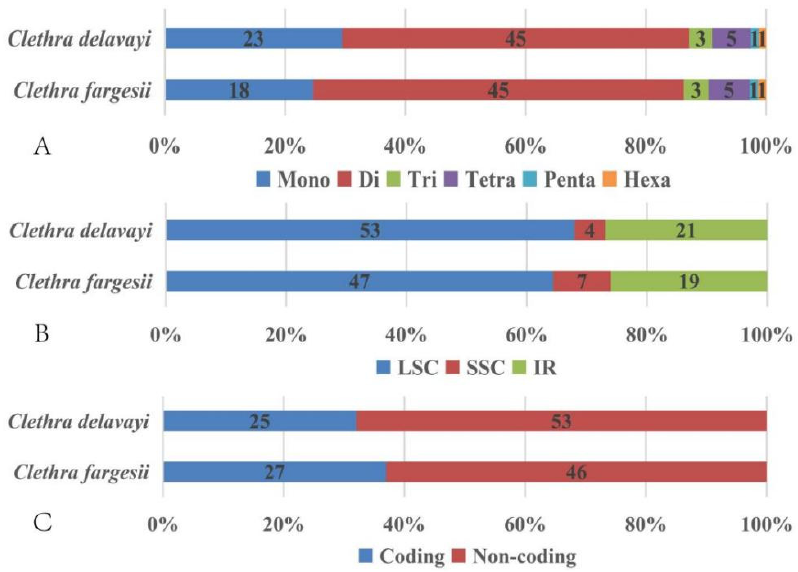
Figure 6. Distribution of simple sequence repeats (SSRs) detected in the chloroplast genome of C. fargesii and C. delavayi . ( A ) The number and proportion of SSR types; ( B ) the number and proportion of SSRs in LSC, SSC, and IR regions; ( C ) and the number and proportion of SSRs in coding sequence (CDS) and non-coding regions.